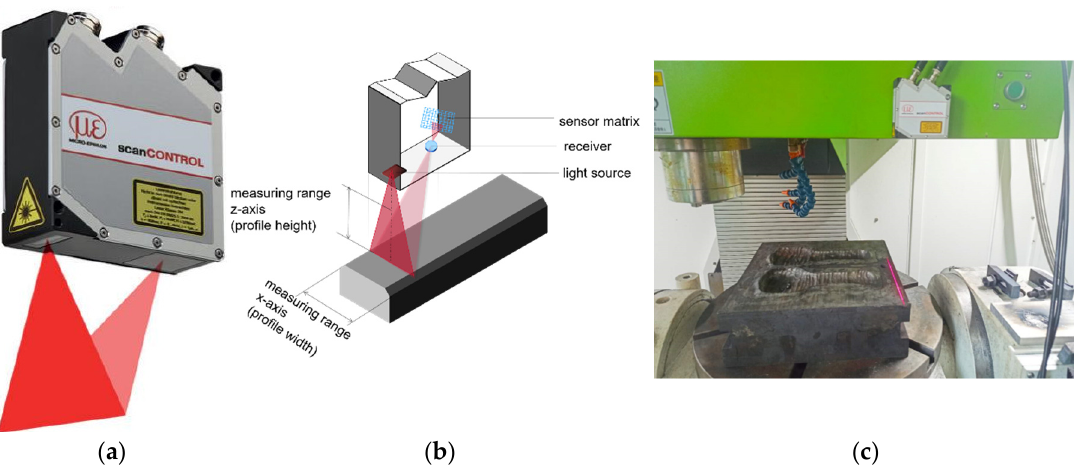
Figure 4. The device used for the point cloud acquisition. ( a ) The scanCONTROL 2900 laser scanner and ( b ) its measuring principle; ( c ) the position of the scanner used in the experiment.